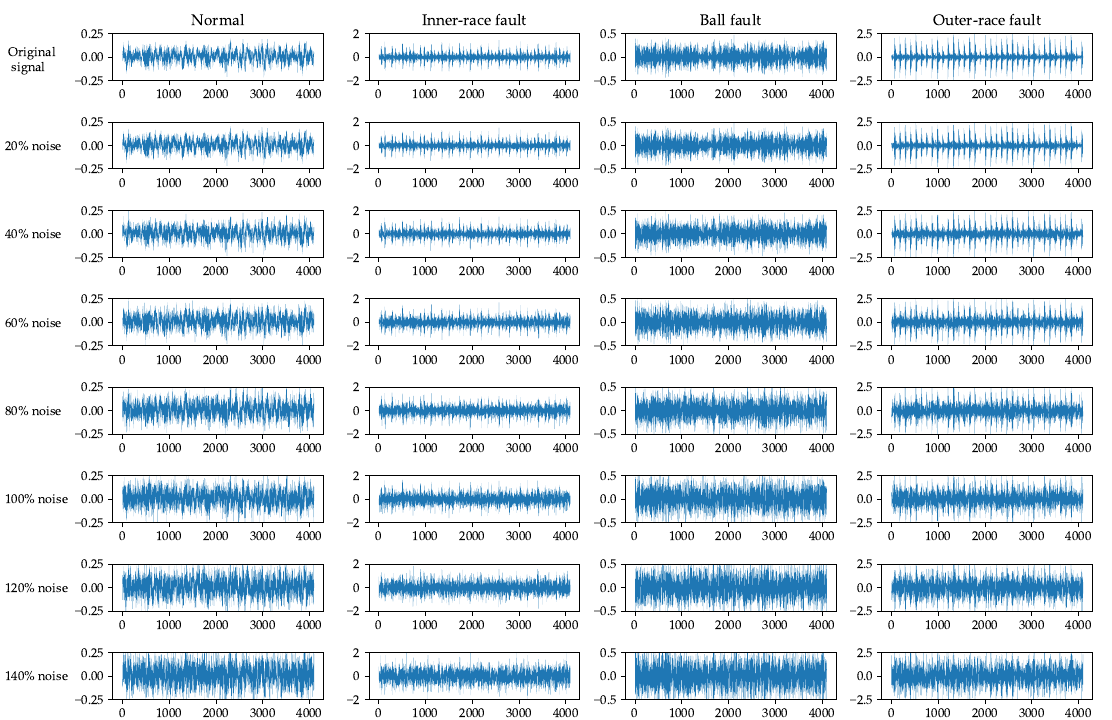
Figure 14. Examples of waveforms of rolling-element bearing vibration signals with different percentages of added noise.